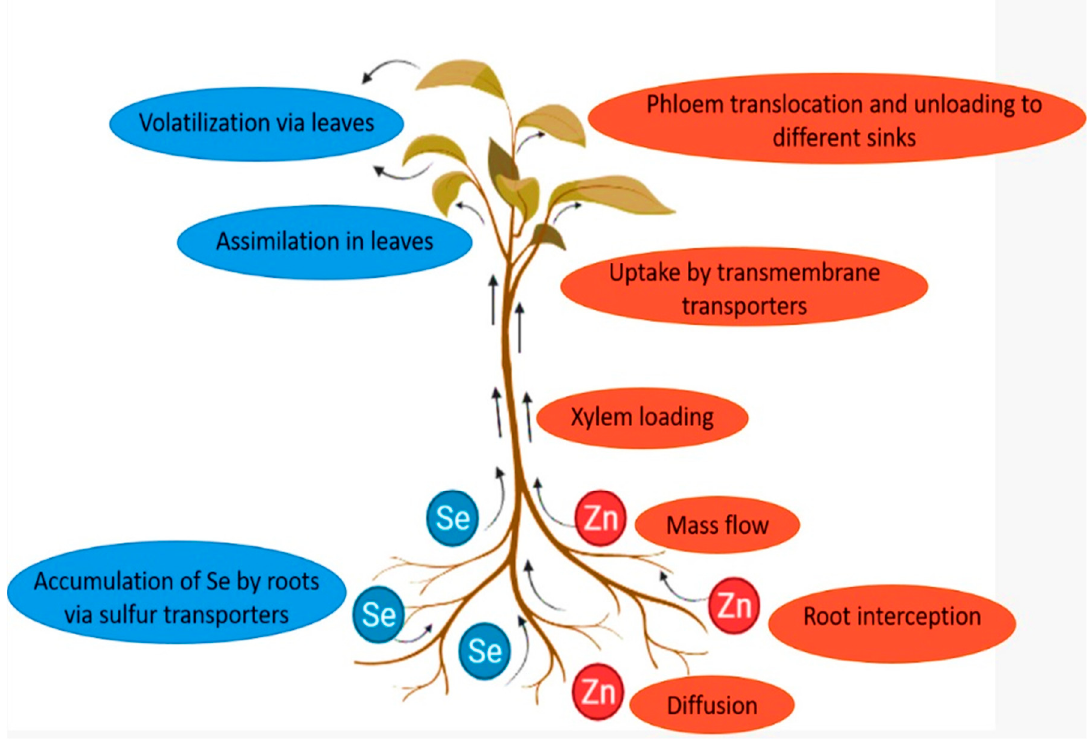
Figure 1. Zinc and selenium uptake and transport in